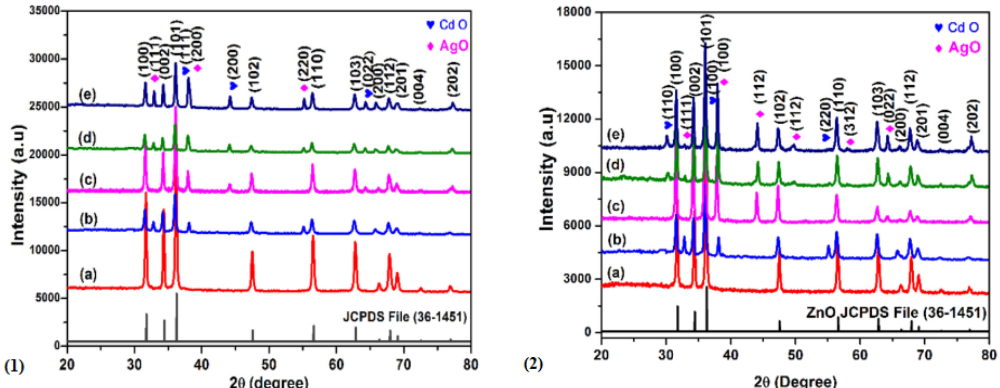
Figure 6. PXRD patterns of as-prepared ZnO (a), Ag:ZnO (b), Cd:ZnO (c), Cd:Ag:ZnO (d), and Cd:Ag:ZnO:PVP (e) materials [60]. Temp = 450 °C ( 1 ) and 600 °C ( 2 ).